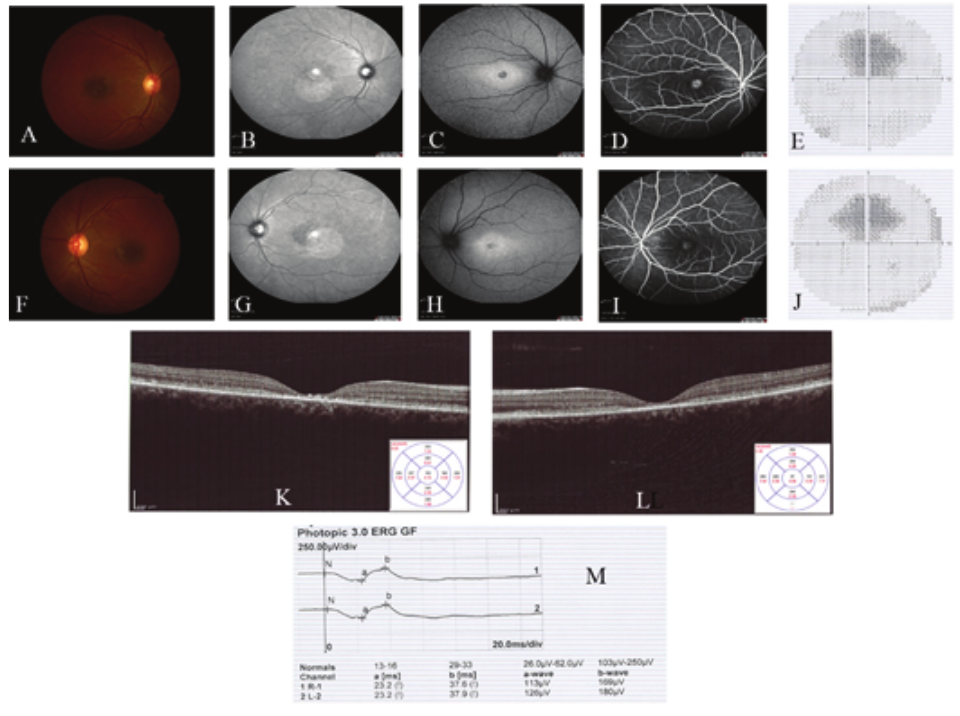
Figure 1. Fundus photographs (color, infrared, and autofluorescence), fluorescein angiography (FA), visual field (VF), optical coherence tomography (OCT), and electroretinography (ERG) findings in a representative patient (STG-5). (A–D) and (F–I) represent color (A & F), infrared (B & G), autofluorescence (C & H), and fluorescein angiographic (D & I) fundus photographs of the patient’s right and left eyes, respectively, and demonstrate the lipofuscin accumulation in the macula. VF defects are evident in the right (E) and left eyes (J). Reduced central macular thicknesses were illustrated in the OCT images of the right (K) and left (L) eyes. Note the abnormal photopic ERG graphs and values for both eyes in